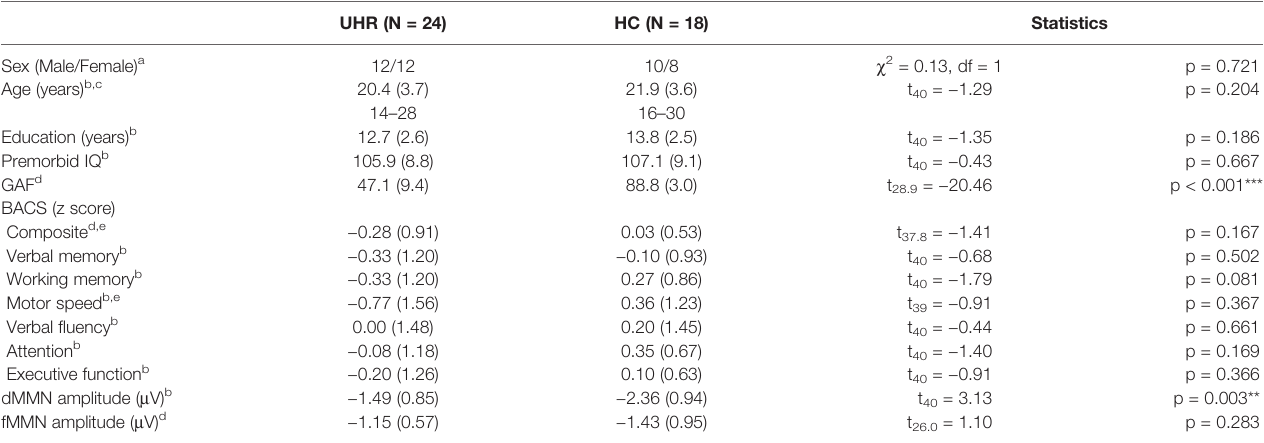
TABLE 1 | Demographic and clinical characteristics of the participants at baseline (Time